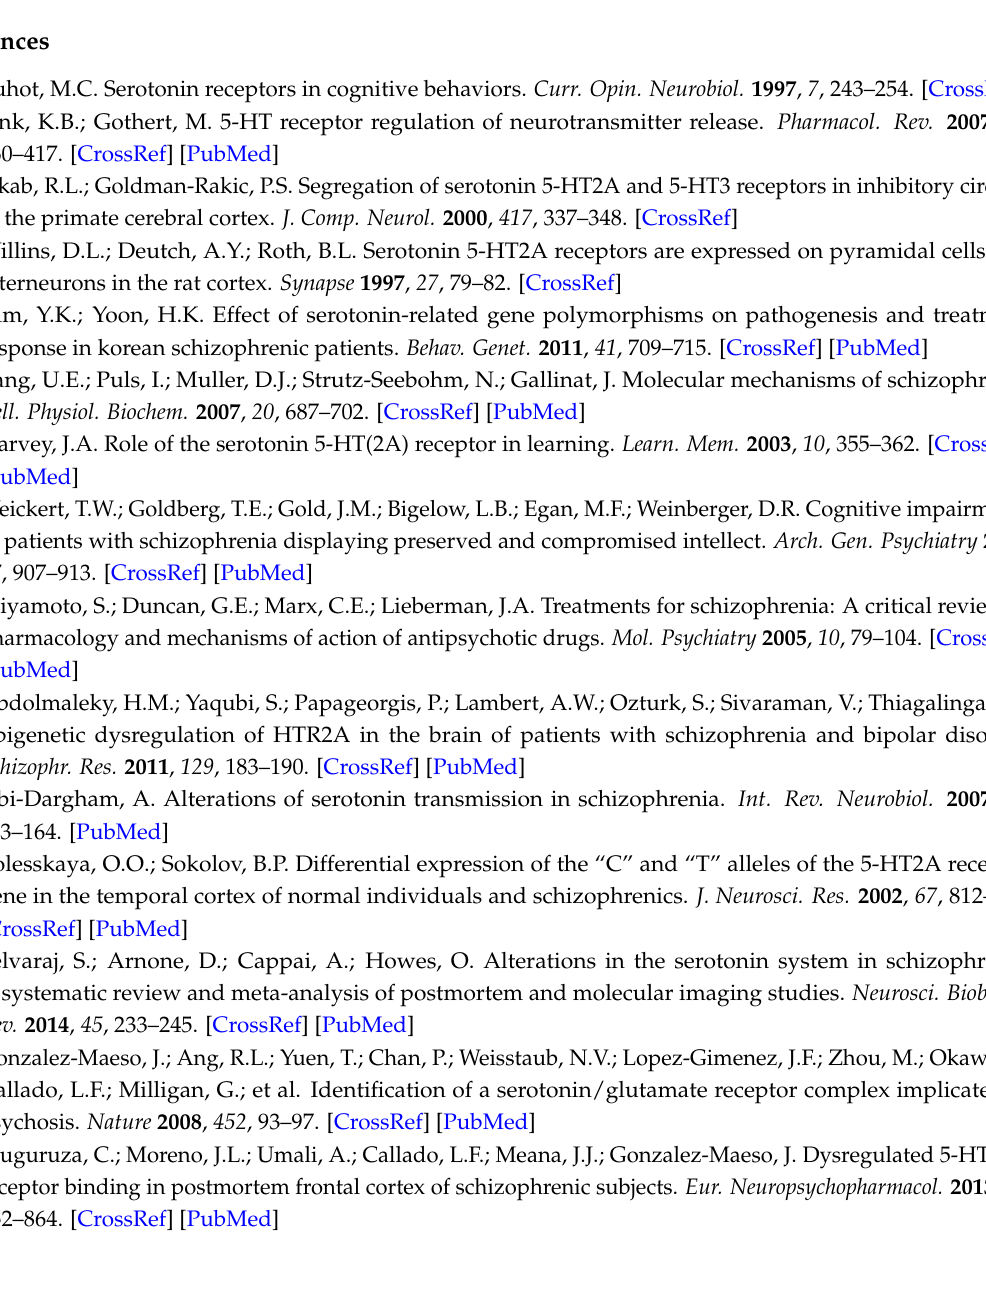
Supplementary Table S1: Complete information of sample age, post-mortem interval (PMI) and gender; Supplementary Table S2: Linear regression results (age and PMI adjusted) of HTR2A mRNA expression and DNA methylation for 10 CpG sites for (a) all subjects (schizophrenic plus control); (b) schizophrenic subjects; and (c) control